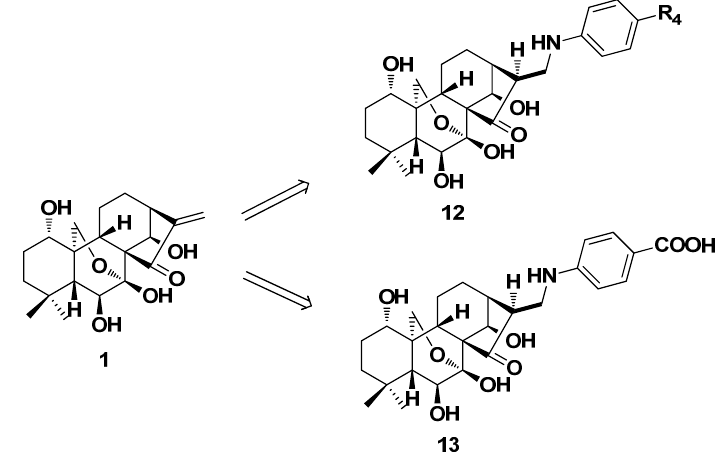
Figure 7. Aromatic amine derivatives ( 12 and 13 ) of oridonin.